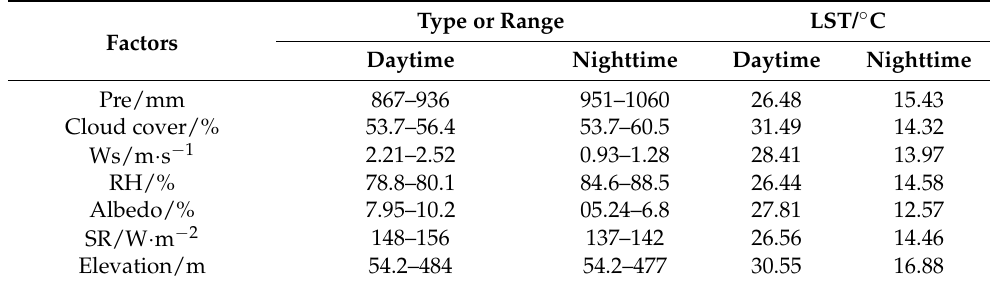
Table 4. Type or range of the influence factors at maximum